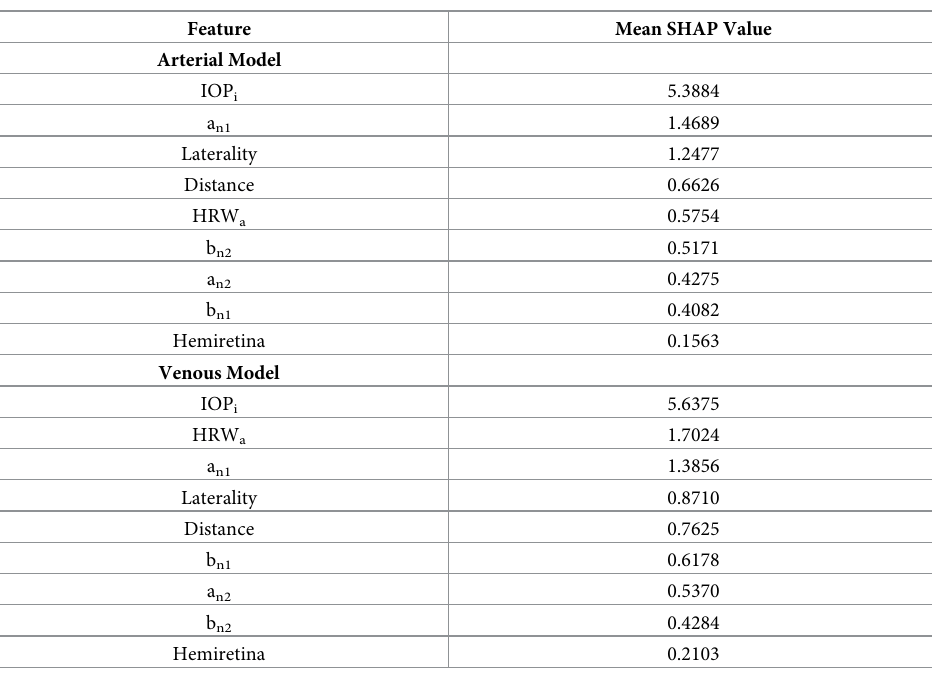
Table 4. Mean SHAP values for the arterial and venous models.